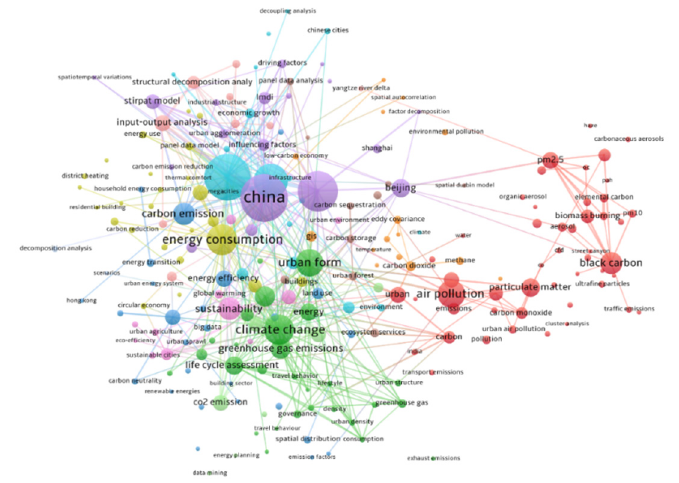
Figure 4. Keywords co-occurrence network.